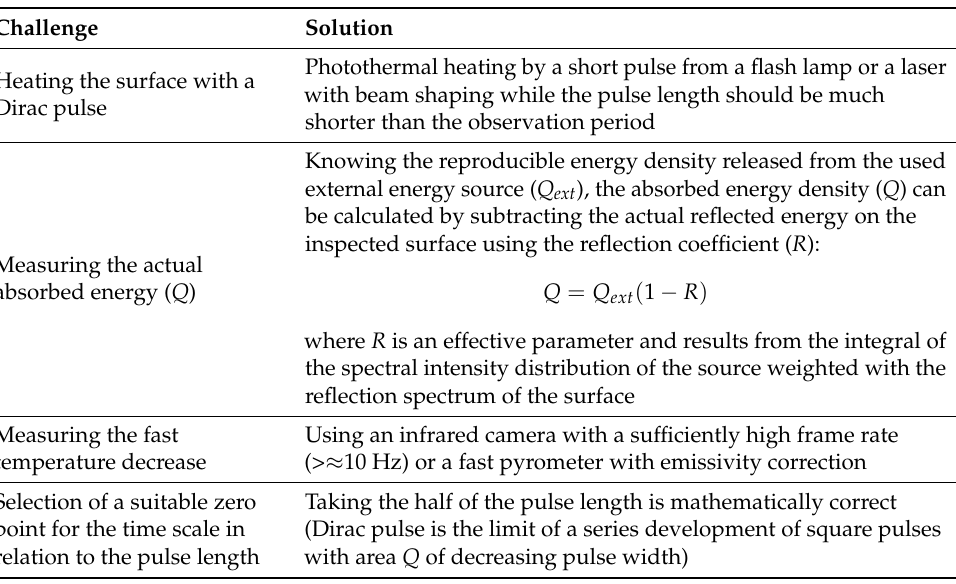
Table 1. Overview of challenges and possible solutions for a technical implementation of the pho- tothermal approach as an on-site inspection